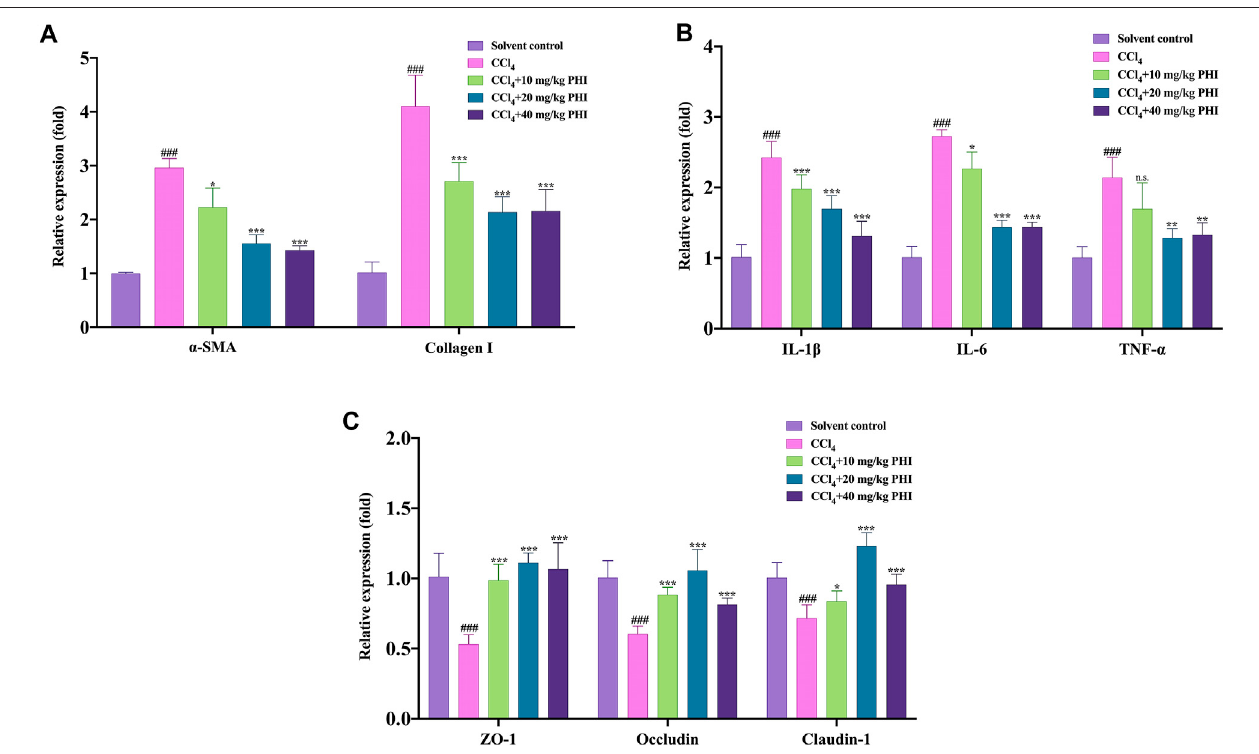
FIGURE10| TherelativemRNAexpressionlevelsinthesolventcontrol,CCl 4 ,CCl 4 +10 mg/ kgPHI,CCl 4 +20 mg/ kgPHIandCCl 4 +40 mg/ kgPHIgroups. (A) The mRNA expressions of α -SMA and Collagen I. (B) The mRNA expressions of IL-1 β , IL-6 and TNF- α . (C) The mRNA expressions of ZO-1, Occludin and Claudin-1. Datawasexpressed asthemean ± SD(n (cid:1) 6). ### p < 0.001representcompared withsolventcontrolgroup.* p < 0.05,** p < 0.01,*** p < 0.001representcomparedwith CCl 4 group. n. s indicates no signi fi